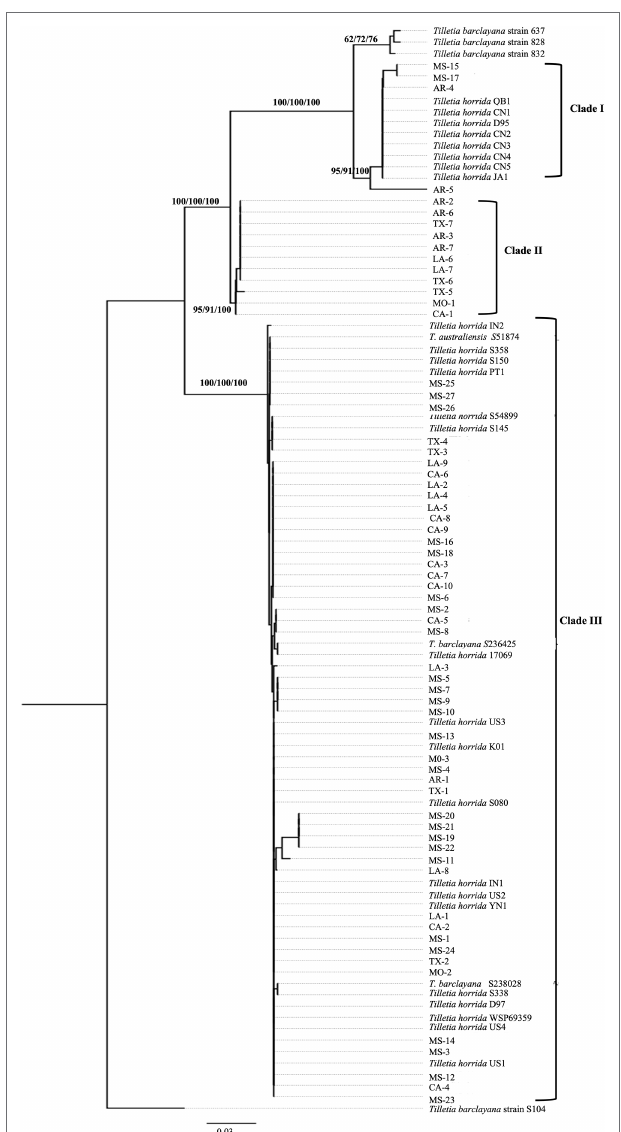
FIGURE 2 | ITS region-based neighbor-joining phylogenetic tree with 63 T. horrida isolates collected Arkansas (AR), California (CA), Louisiana (LA), Mississippi (MS), Missouri (MO), and Texas (TX) in the US in the current study, along with 33 ITS sequences obtained from the NCBI database. T. horrida strain QB1 was used as a reference isolate and T. barclayana S104 was used as an outgroup. The scale bar represents the number of substitutions per site. The values on the branches indicate the percentage of trees based on 1,000 bootstrap replicates on ML/NJ/ME, respectively. Only branches values with >50% replicates are